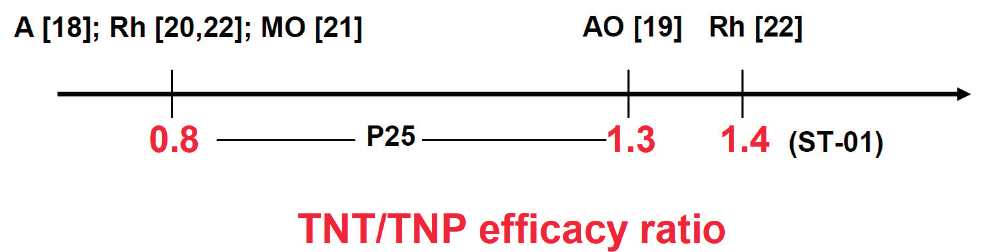
Figure 7. TNT/TNP efficacy ratio in the photocatalytic removal of dyes: amaranth (A), rhodamine B (Rh), methyl orange (MO), and acid orange 7 (AO). The TNP were P25 except in one case as is shown. The corresponding references are indicated in